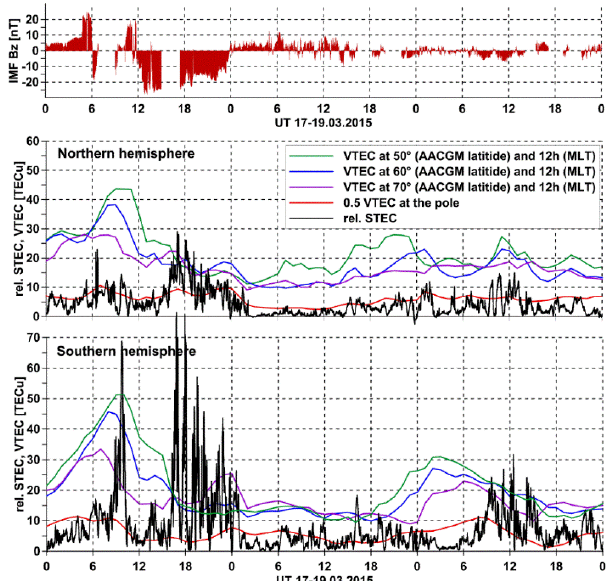
Figure 8. Variations of IMF Bz (top panel) and maximal relative STEC values for sectors given in Figure 7 (middle and bottom panels). In the latter case, VTEC on the dayside ionosphere and at the poles are